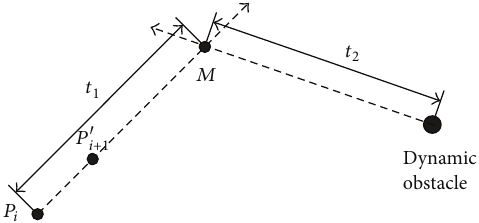
Figure 2: Schematic diagram of dynamic obstacles avoidance for